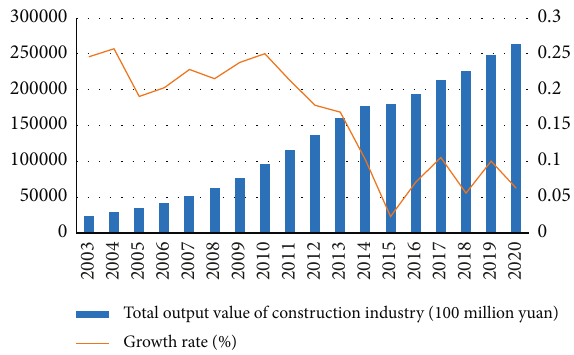
Figure 1: 2003–2020 economic growth trend of construction